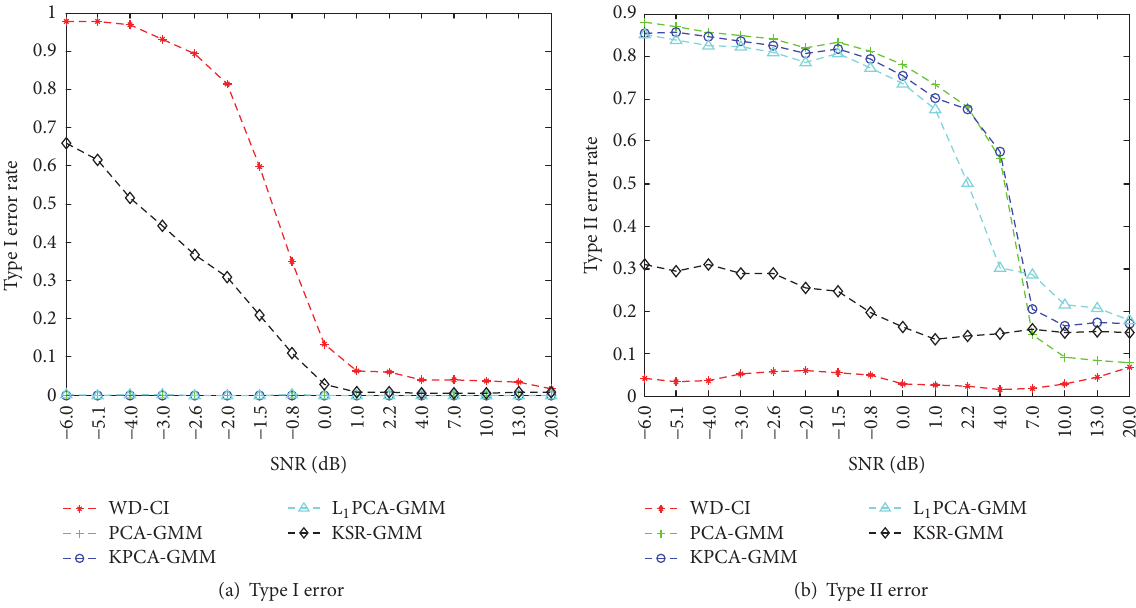
Figure 4: Statistical results by different methods at different SNRs which are systematically varied by changing the variance of the white noise superimposed in the signal.